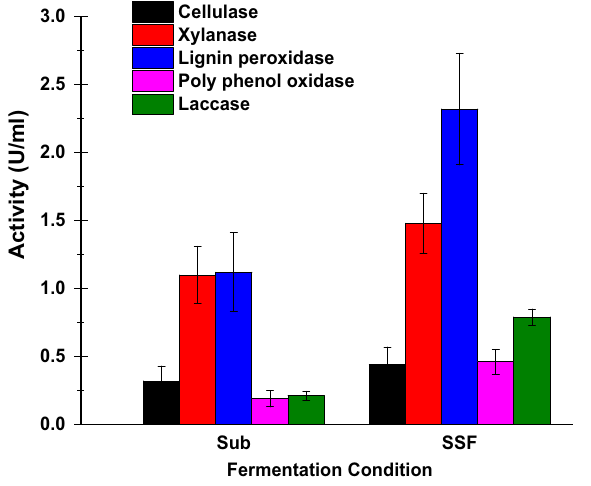
Figure 2. The lignocellulosic enzymes assay for submerged (Sub) and solid stated fermentation (SSF) conditions.